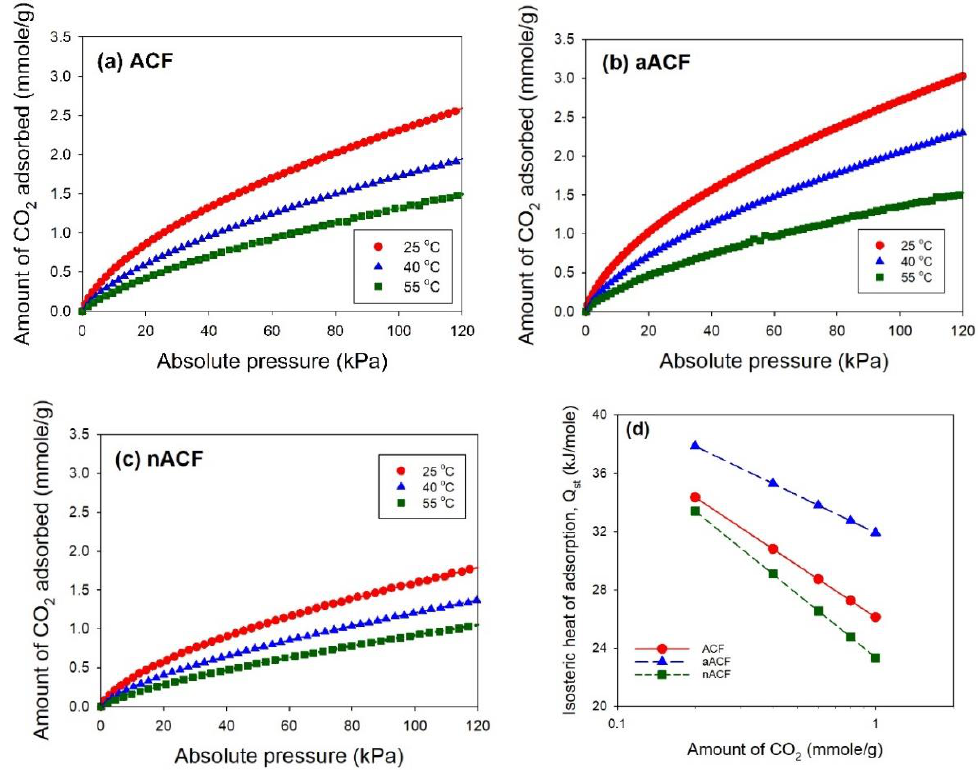
Figure 6. Adsorption isotherms of CO 2 of the samples: ( a ) as ‐ received ACF; ( b ) KOH ‐ activated ACF (aACF); ( c ) TEPA ‐ modified ACF (nACF) and ( d ) the isosteric heat of adsorption (Q st ) of CO 2 .